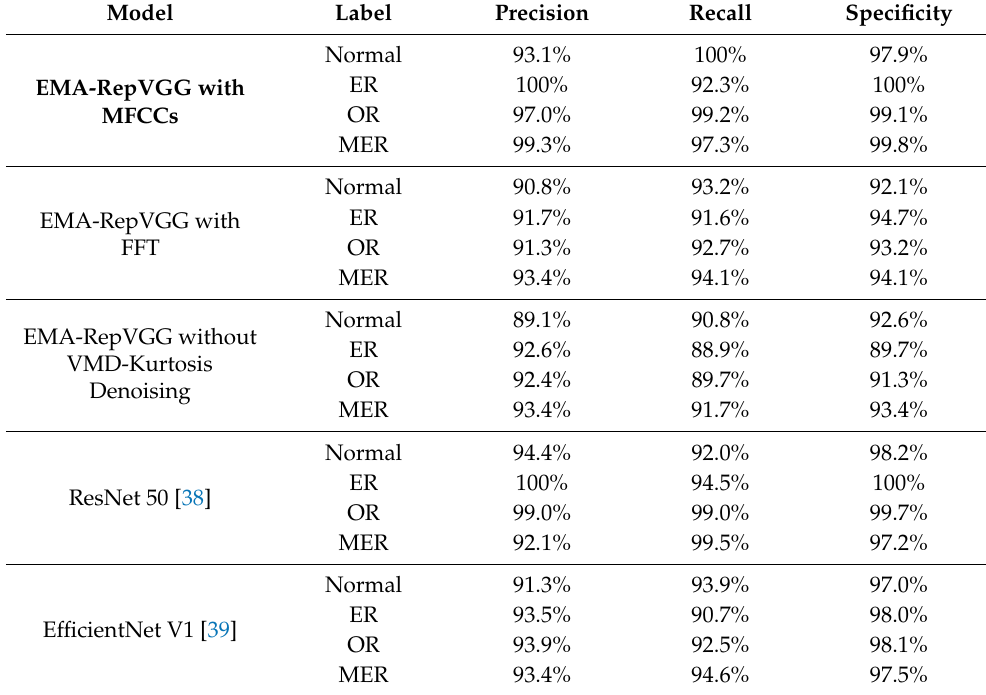
Table 8. Precision and recall of diagnosis